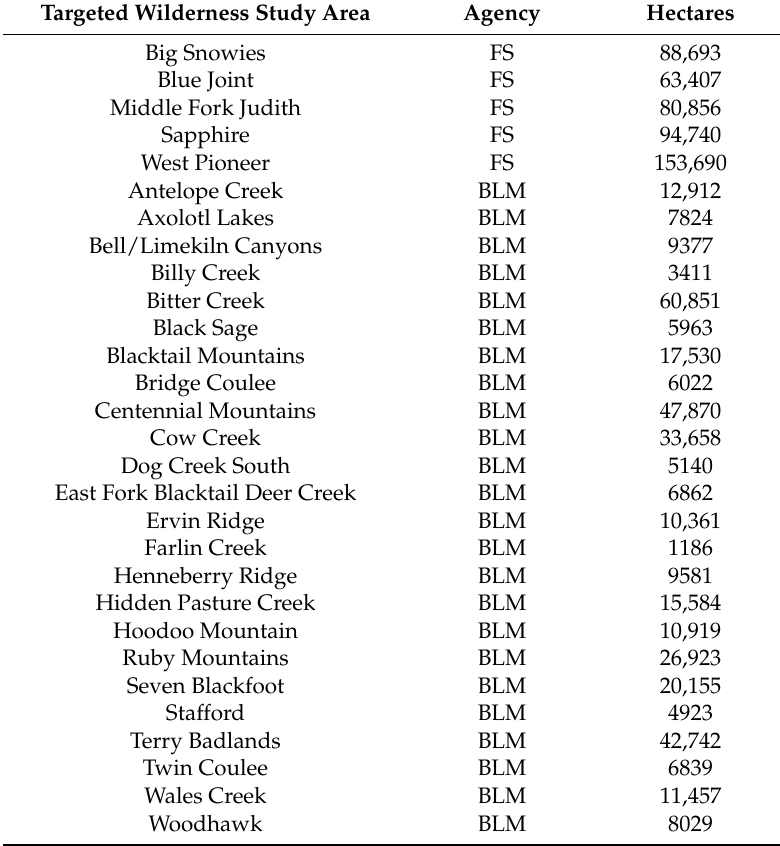
Table 2. Wilderness Study Areas targeted for release via recently proposed legislation to the U.S. Senate and House of Representatives. FS: U.S. Forest Service; BLM: Bureau of Land